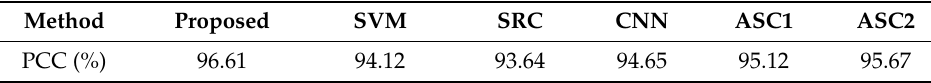
Table 7. PCCs of different methods under configuration